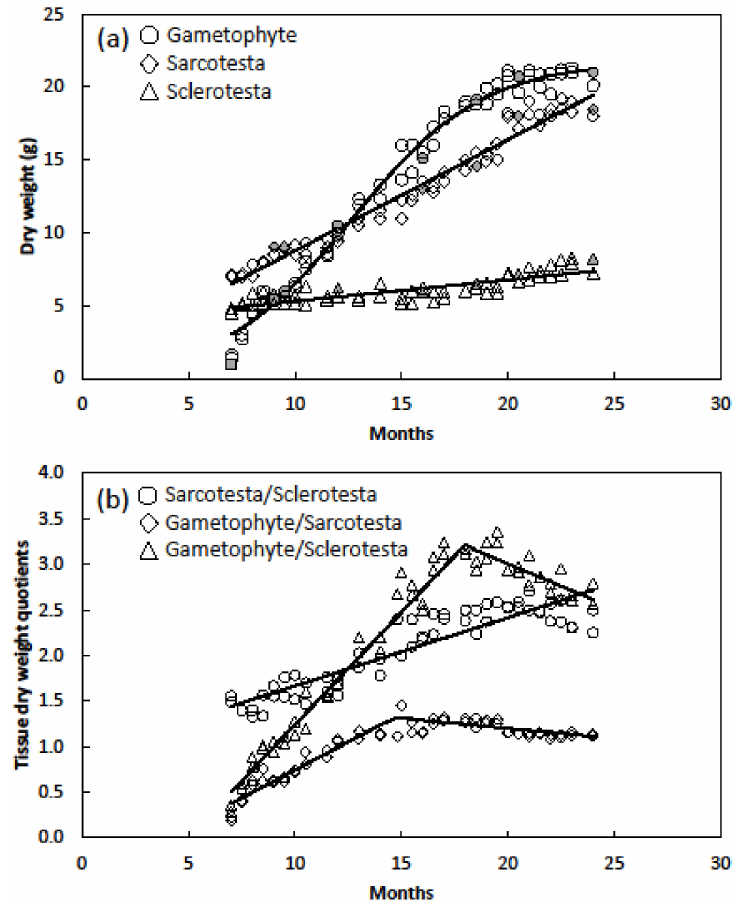
Figure 5. Dry weight of Cycas micronesica seeds from 7 to 24 months in age. Open symbols repetitively sampled trees, shaded symbols single harvest trees. ( a ) Absolute dry weight. Gametophyte: y = 21.770 / (1 + exp(4.088-0.324x)), p ≤ 0.001, r 2 = 0.99, Sarcotesta: y = 1.15 + 0.76x, p ≤ 0.001, r 2 =